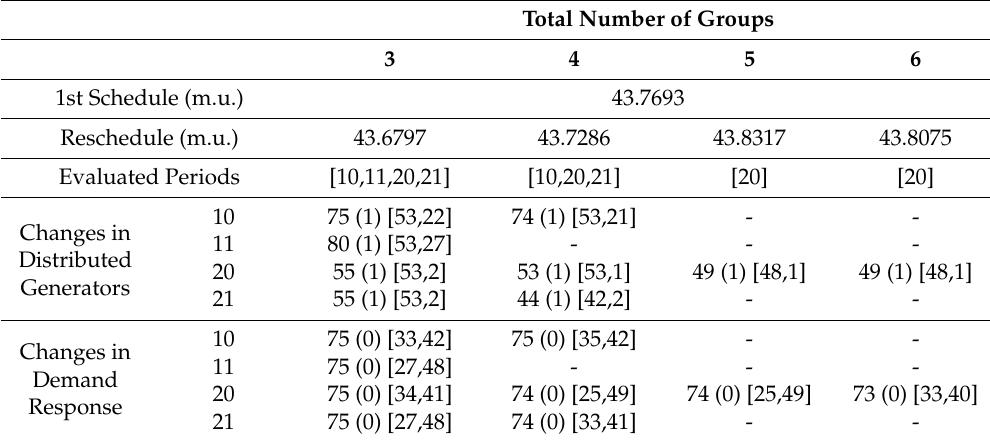
Table 2. Summary of results from